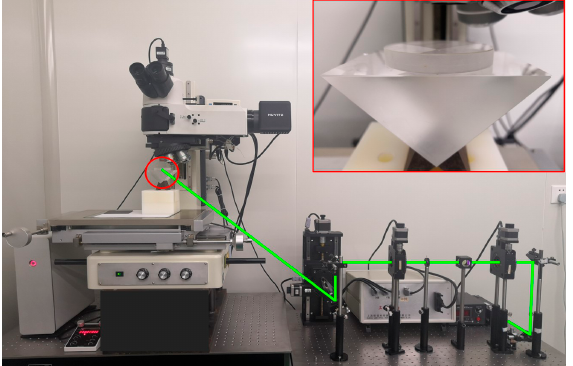
Figure 7. Photograph of our improved